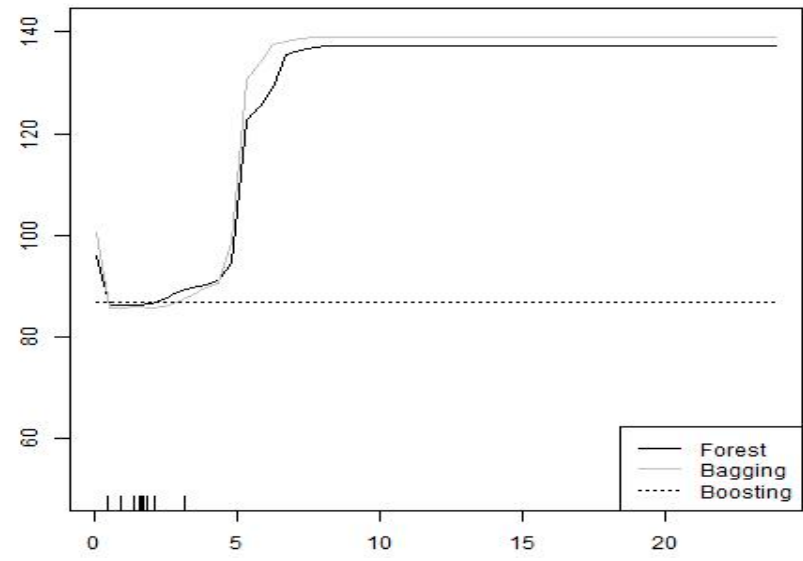
Figure 3. Partial dependence plot: military personnel.